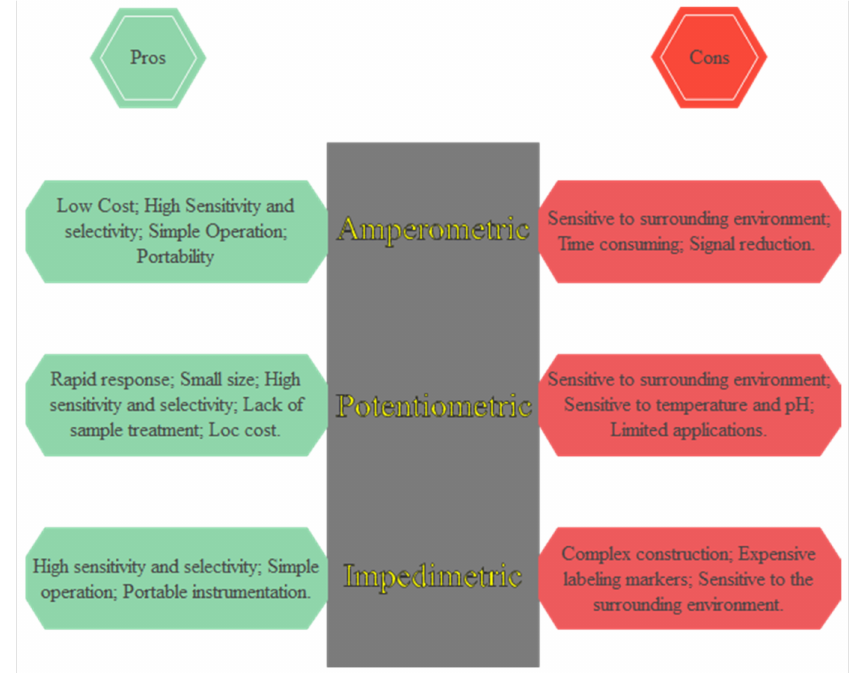
Figure 3. Comparison of electrochemical